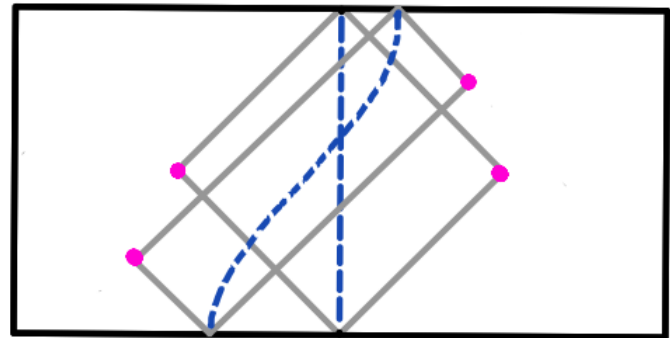
Figure 3. Two static patches in the same